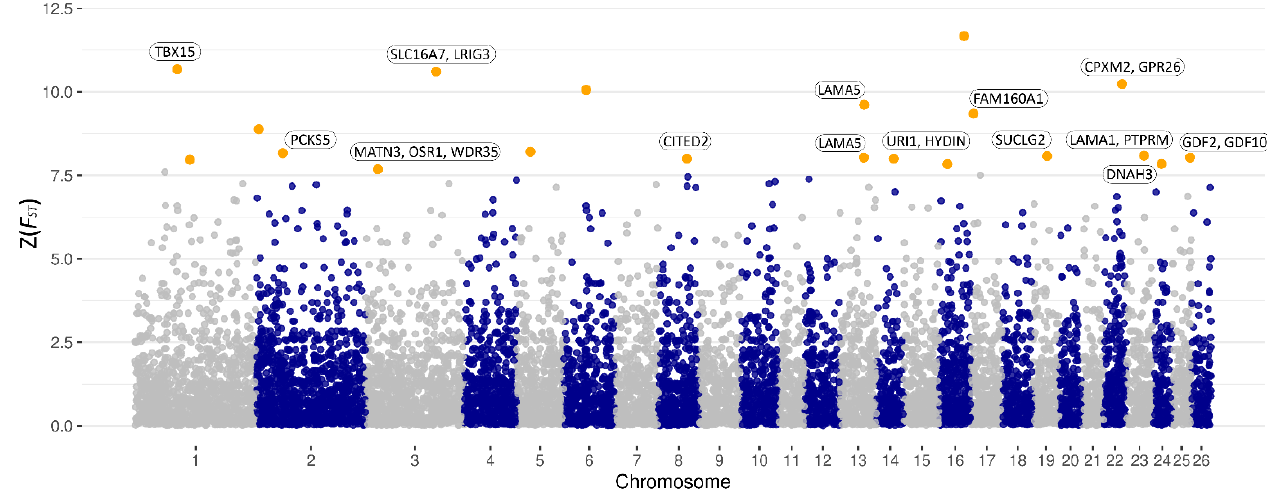
Figure 2. Manhattan plot of the Z( F ST ) values for each single nucleotide polymorphism (SNP) between Barki sheep groups divergent in birth weight (LBW–HBW). Orange dots represent SNPs that passed the cutoff threshold at 99.95% of the percentile distribution (Z( F ST ) ≥ 7.68). Table 2. Genomic positions of SNPs that exceeded the cutoff threshold (Z( F ST ) ≥ 7.68) for divergence in birth weight and adjacent candidate genes within a 2 Mb window.